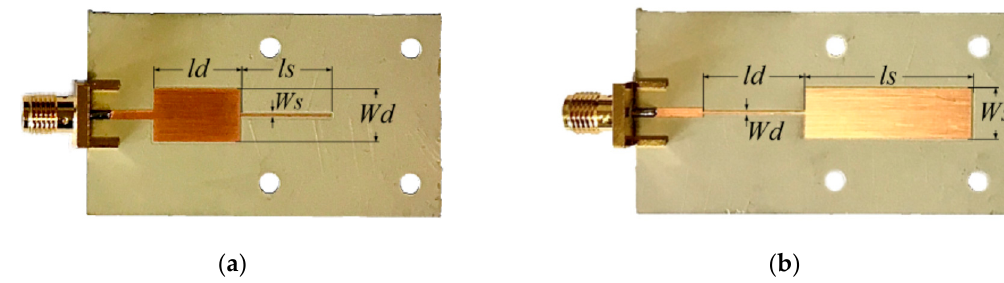
Figure 2. Photographs of the designed and fabricated reflective-mode phase variation sensors. ( a ) Sensor A; ( b ) sensor B. For sensor A, the dimensions (in mm) are as follows: W d = 7.5, l d = 12.8, W S = 0.235 and l S = 13.5. For sensor B, the dimensions (in mm) are as follows: W d = 0.32, l d = 14.6, W S = 7.5 and l S = 24.4.